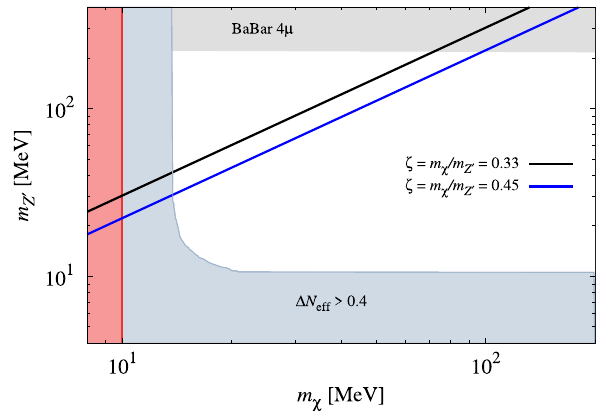
Fig. 4 The contour plots between the m Z (cid:2) and m χ , for two different ratios ζ = m χ / m Z (cid:2) = 0 . 33 , 0 . 45 that yield the observed DM density for the couplings g (cid:2) that satisfy Δ a μ . The grey, light blue and light red shaded region are excluded by the BaBar experiments, Δ N eff > 0 . 4 and the CMB and BBN